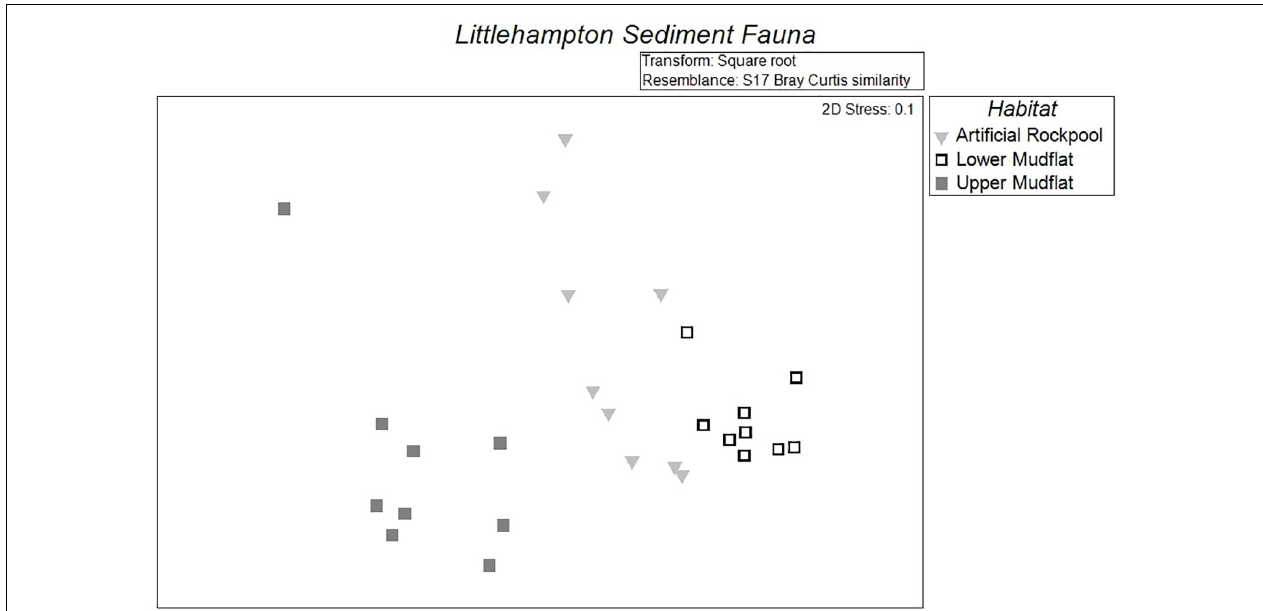
FIGURE 7 | Multidimensional scaling (MDS) plots demonstrating the similarities of assemblages in the different soft-bottom habitats: artificial rockpool, lower mudflat, and upper mudflat ( n =